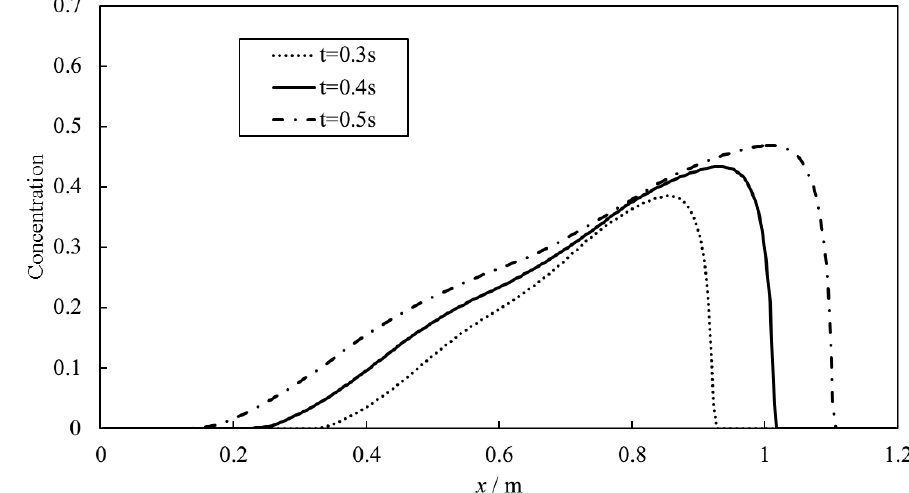
Figure 8. Simulated sediment concentration along the flood direction at different